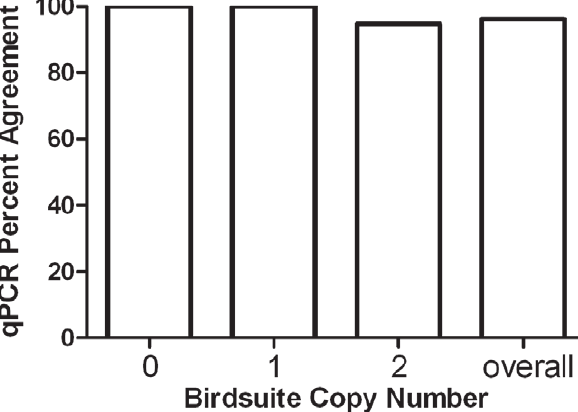
Figure 1. Percent agreement between Birdsuite copy number calls and qPCR. Percent agreement between the Affymetrix array copy numbers, as determined by the Birdsuite software, and qPCR copy number, determined using DD Ct calculations, is plotted for each copy number class. Percents are based on 214 comparisons from copy numbers for 37 samples on 6 distinct chromosomal regions (7q33, 8q11, 8q24, 15p13, 16p12). For copy number 0, 6/6 samples agreed (100%). For copy number 1, 45/45 samples agreed (100%). For copy number 2, 127/134 of samples agreed (94.7%). The overall agreement is 178/185 samples